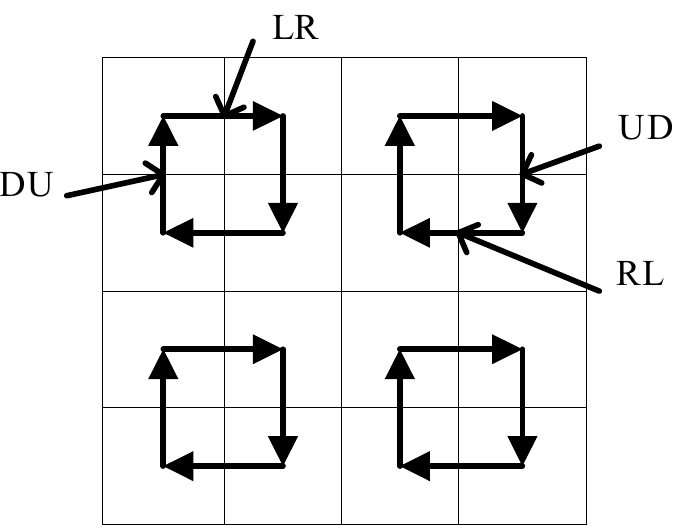
Figure 6. Di ff erence direction matrix of 4 × 4 sub-blocks. Figure 6. Difference direction matrix of 4 × 4